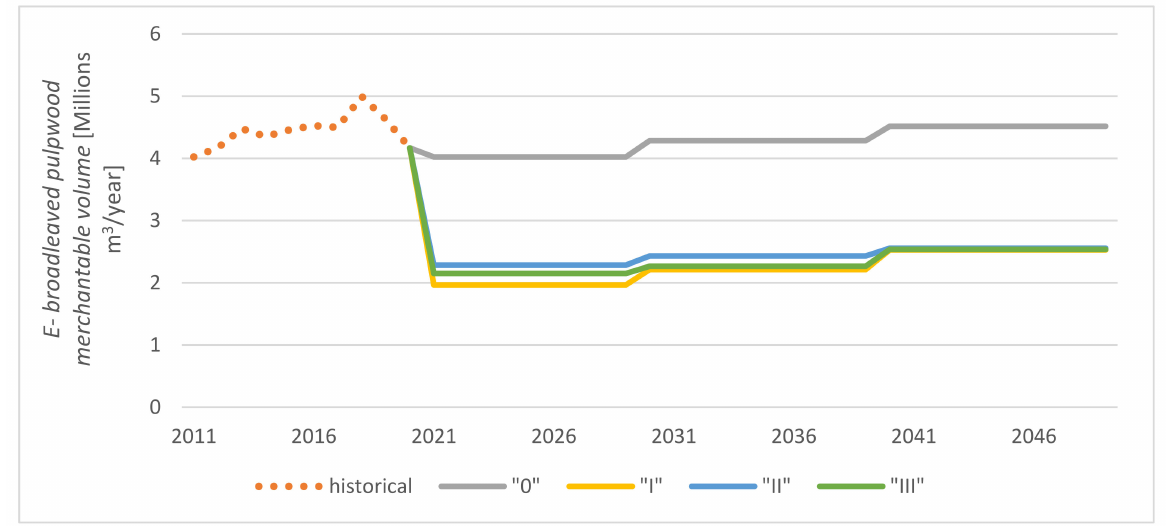
Figure 5. Change in the amount of harvested merchantable broadleaved pulpwood volume in the scenarios against the background of the historical harvesting size of merchantable broadleaved pulpwood